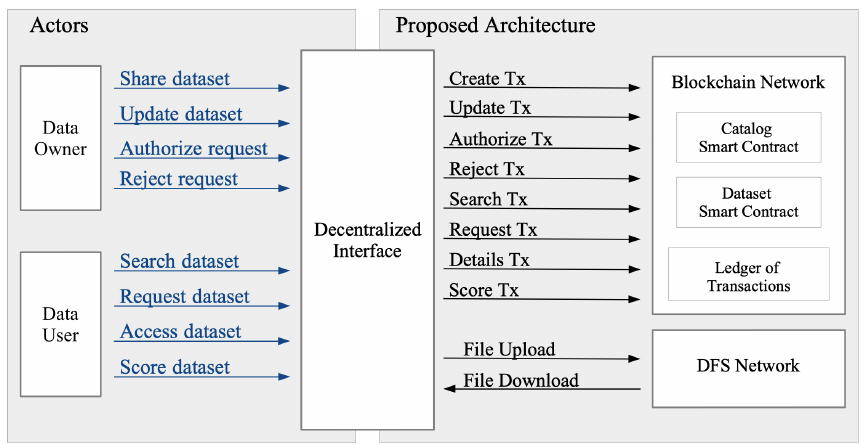
Figure 4. Modular view of the proposed system with the focus on the actors and their interactions.